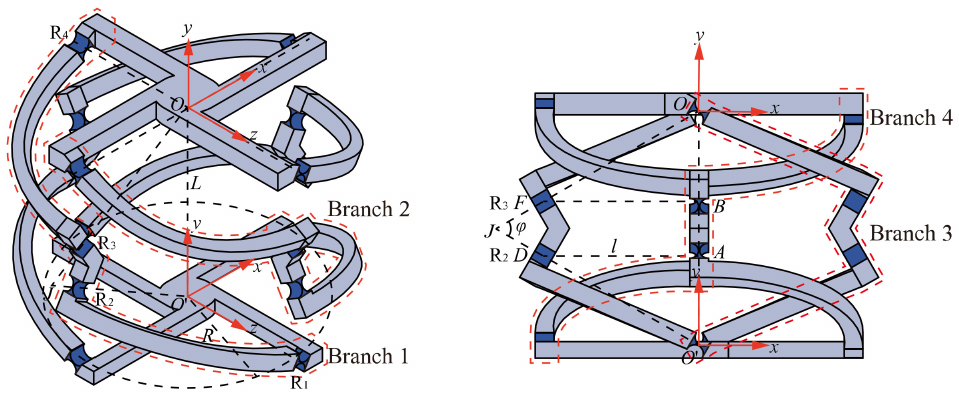
Figure 2. Structure parameters of 4-4R compliant parallel pointing